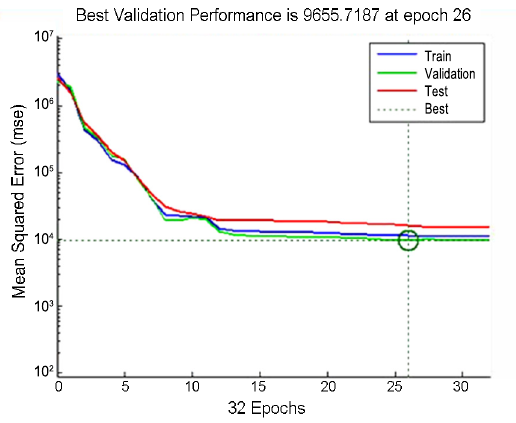
Fig. 5. Training, validation, and test root mean squared error values